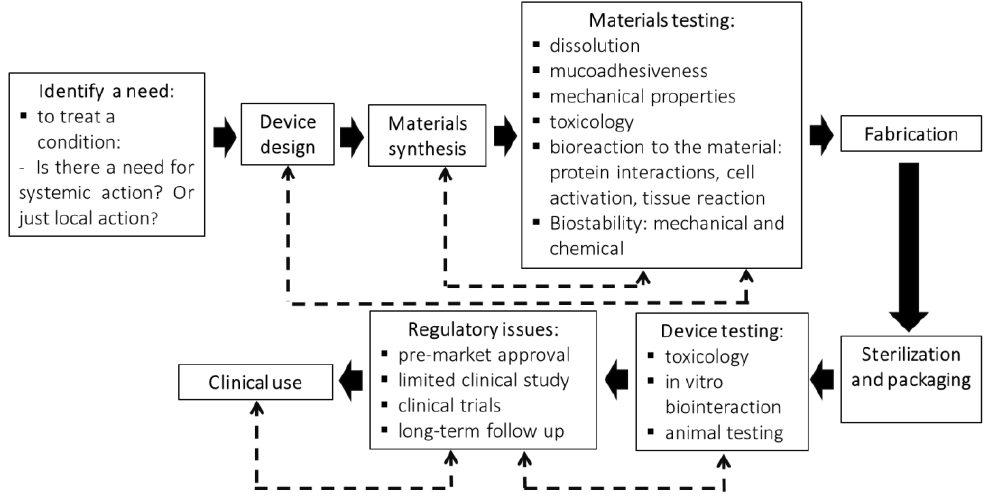
Figure 6. Illustrative diagram of the steps for the development of a new biomaterial designed for drug delivery to the oral cavity. Dashed lines refer to steps in which retro-feedback may occur with the purpose of improving the biomaterial originally designed (adapted from [127,128]).